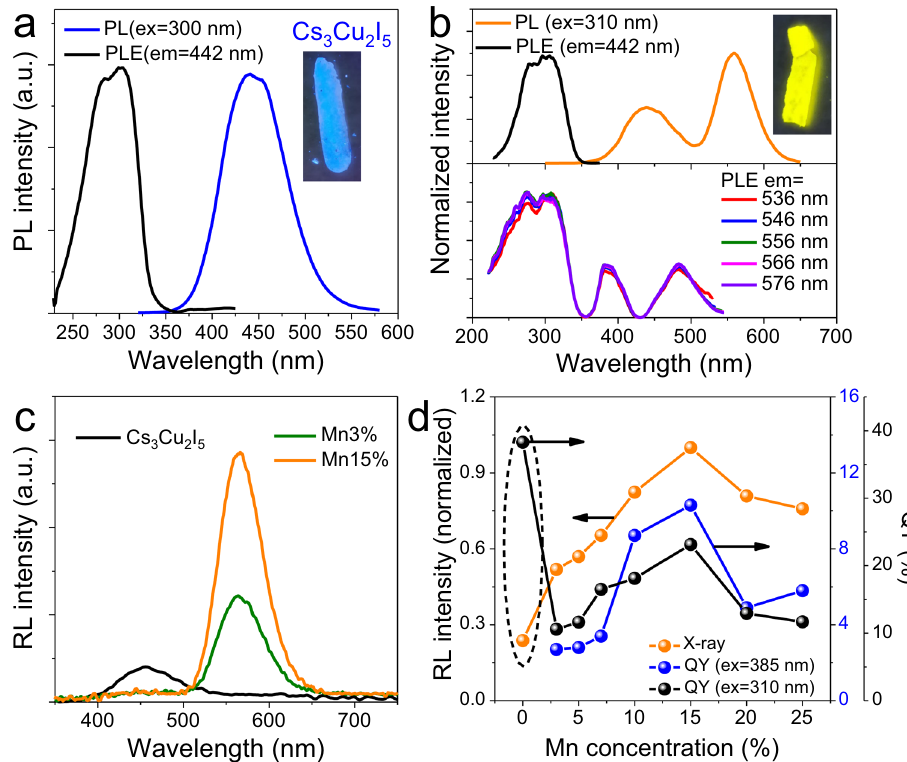
Fig. 2 Optical and anomalous scintillation properties. a PL and PLE spectra of undoped Cs 3 Cu 2 I 5 measured/monitored at 300 and 442 nm. The inset shows the image under 254 nm UV light. b PL and PLE spectra of Mn15% measured/monitored at 310/442 nm (top part), and PLE spectra monitored at 536 – 576 nm (bottom part). The inset shows the image under 365 nm UV light. c RL spectra of Cs 3 Cu 2 I 5 :Mn with doping concentrations of 0%, 3%, and 15%. d RL intensity and PL QYs of samples under intrinsic (310 nm) and direct Mn 2 + (385 nm) excitations as a function of doping